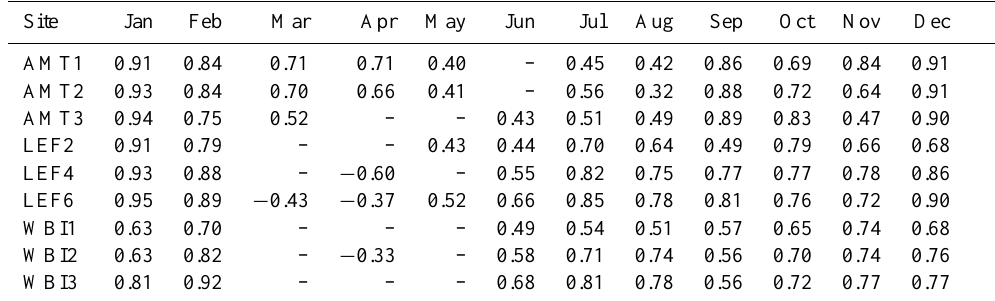
Figure 5. Daily mean total column dry molar fraction [ppm] of CO 2 at TCCON sites from measurements (dark circles) and hindcast (blue triangles) in 2010. Error bars indicate the uncertainty associated with observations. The delta and the sigma values are the mean and standard deviation of the model minus TCCON data. Table 2. Correlation between observed and modelled daily mean CO 2 at several sites from the NOAA/ESRL tower network. Correlation coefficient values are significant at the 90% level, dashes indicating the correlation coefficients are not significant. Station locations and sampling heights are shown in Tables 1 and